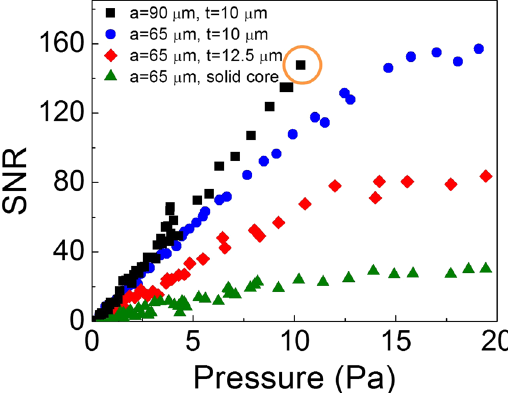
Figure 3. SNR vs. various 800 kHz ultrasound peak-to-peak pressures for three capillary-based ring resonators and a solid-core ring resonator. The physical dimensions of the capillaries are given in the legend of the plot. a is the outer diameter; t is the wall thickness. The slope in the linear region represents the ring resonator pressure sensitivity. The results show that larger resonators with thinner wall have higher pressure sensitivity, as predicted by Eqs (3) and (4). The temporal response for the data point in the orange circle is given in Fig. 2b.